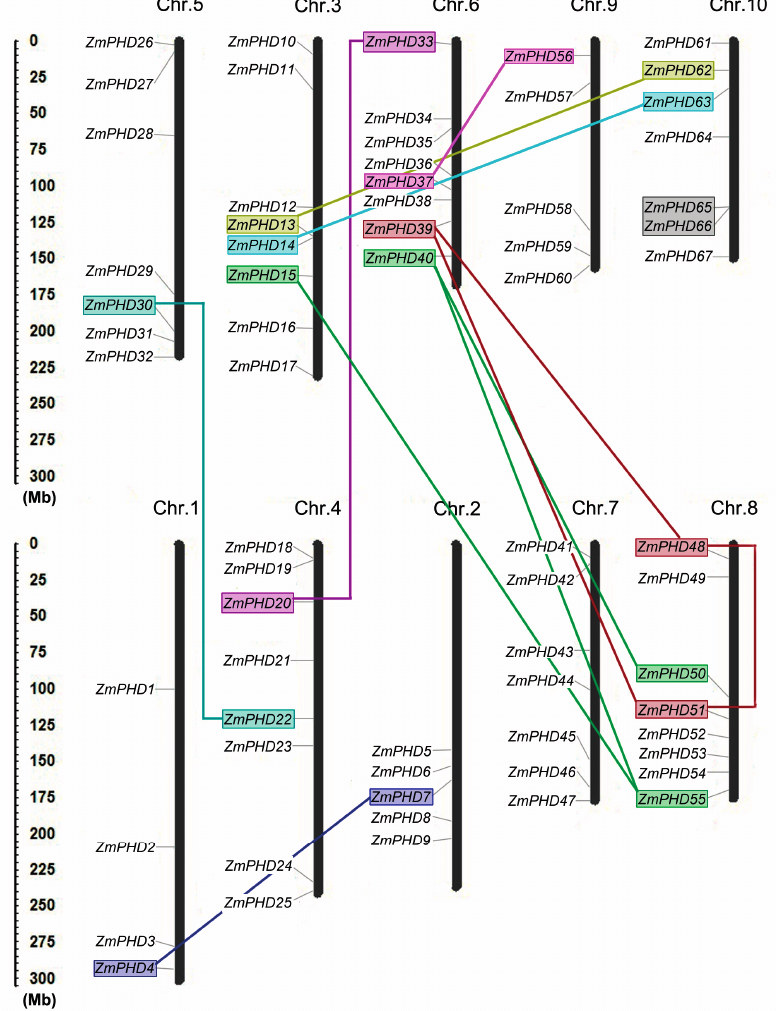
Figure 4. Chromosomal locations of maize PHD genes. The left scale represents the megabases (Mb). Chromosome numbers are shown at the top of each vertical black bar. The rough location of each maize PHD genes is marked whit the grey line that link the gene names with the chromosome bars. The segmental duplication gene pairs are marked with color boxes and joined by corresponding color lines, and the grey box indicates the tandem duplication gene